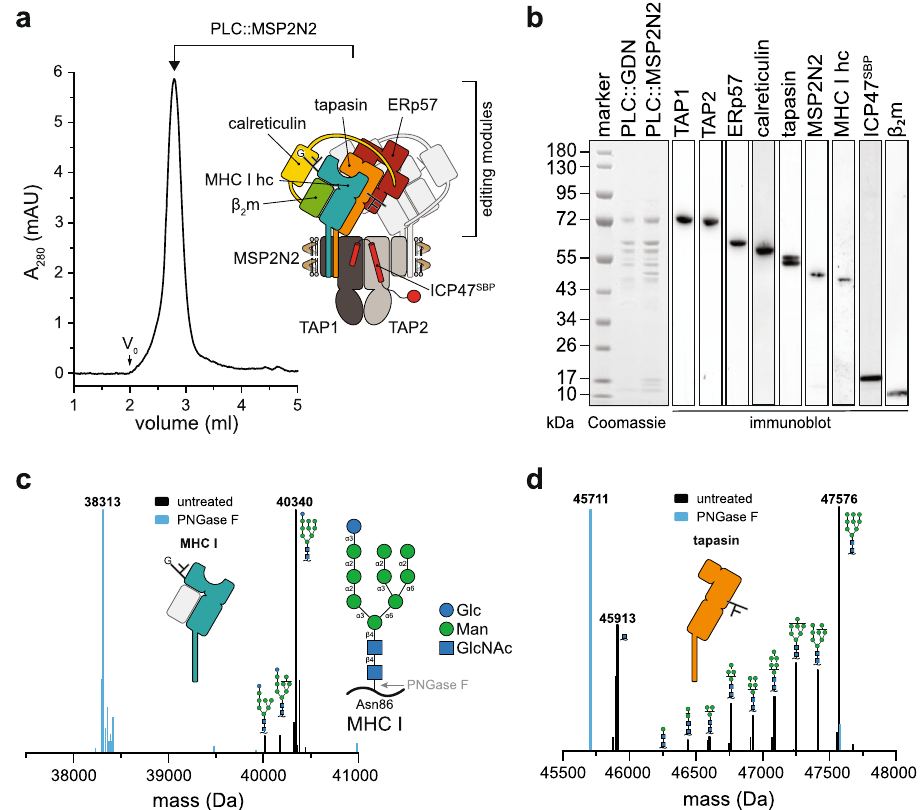
Fig. 1 | PLC reconstituted in large lipid nanodiscs displays distinct glycosyla- tion modi fi cation of MHC I and tapasin. a PLC reconstituted in large lipid nanodiscs (PLC::MSP2N2) analyzed by size-exclusion chromatography (SEC). The PLC contains two editing modules, centered around the peptide transporter TAP1/2. For better visualization, one of the two editing modules is shown in light grey. b Compositional analysis of human PLC puri fi ed by ICP47 SBP in detergent (PLC::GDN) and reconstituted in lipid nanodiscs (PLC::MSP2N2) by SDS-PAGE, immunoblotting, and LC-MS (Supplementary Fig. 1 and 2). c Glycosylation pattern